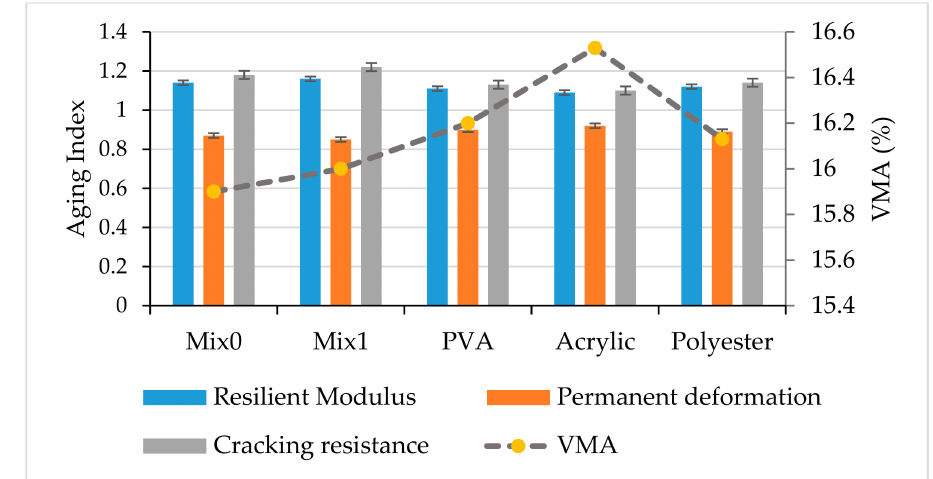
Figure 10. E ff ect of VMA of the asphalt mixes on the aging